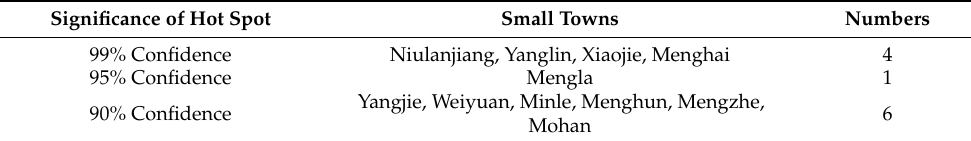
Table 8. Cluster results of social livelihood dimension.